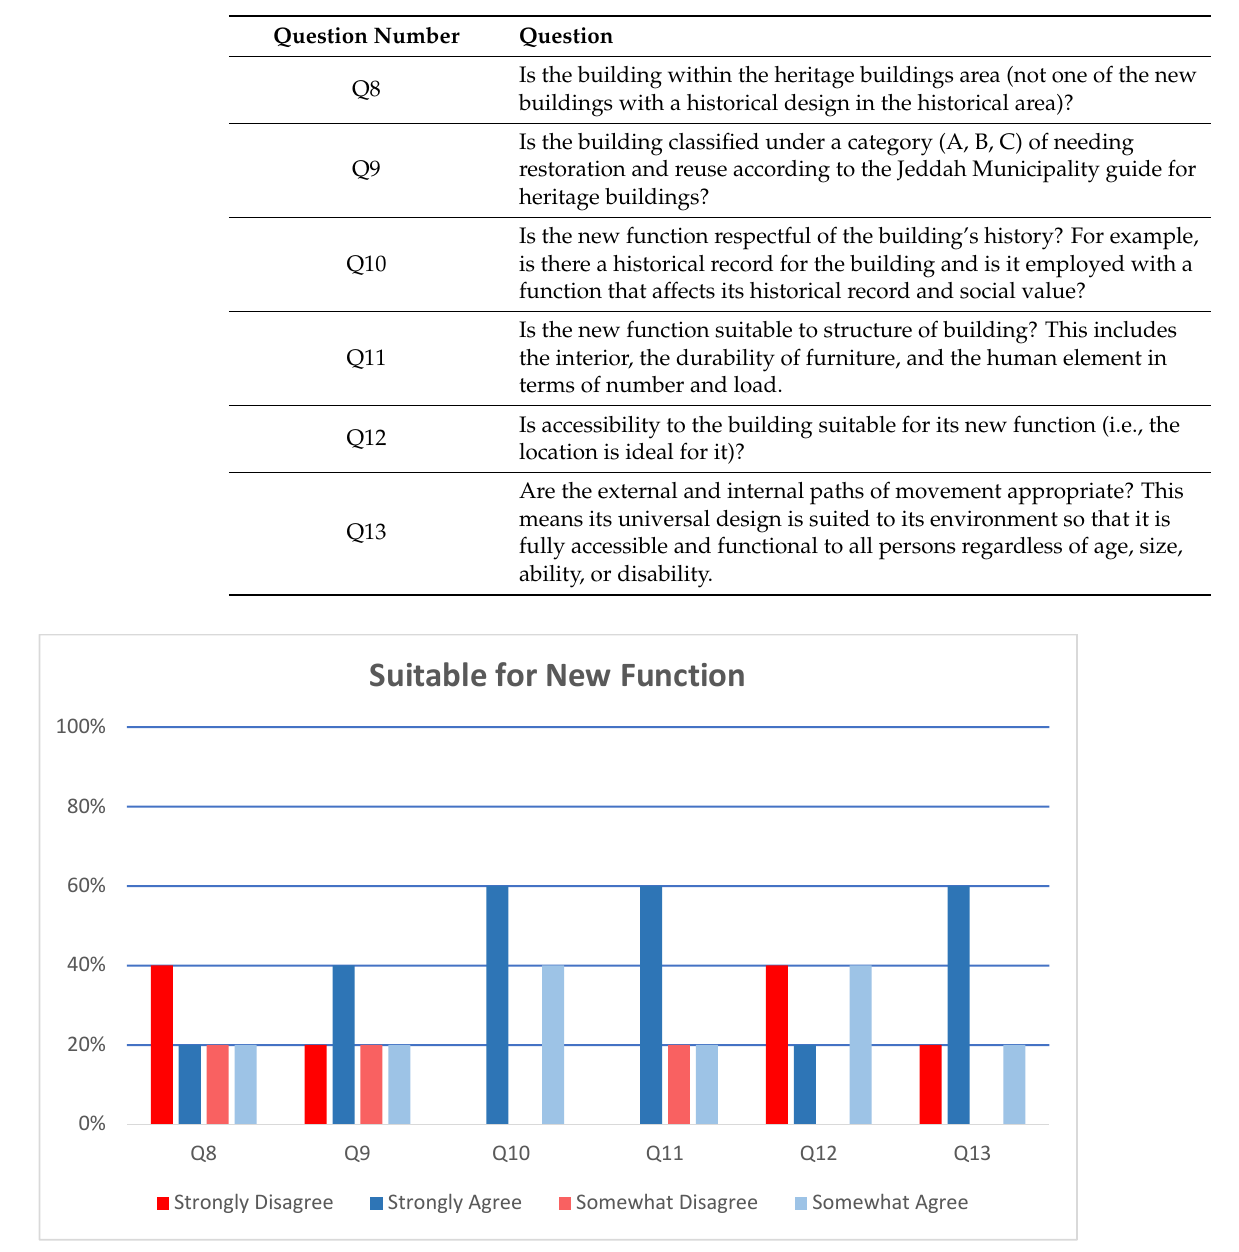
Figure 7. Results of suitable for new function.